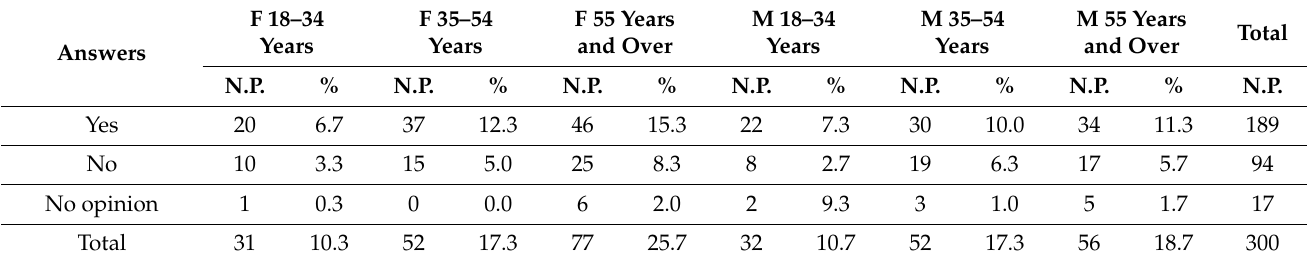
Table 4. Respondents’ answers (by sex and age) to the question: should a green area in your area be a more accessible forest or park? (Source: the authors).